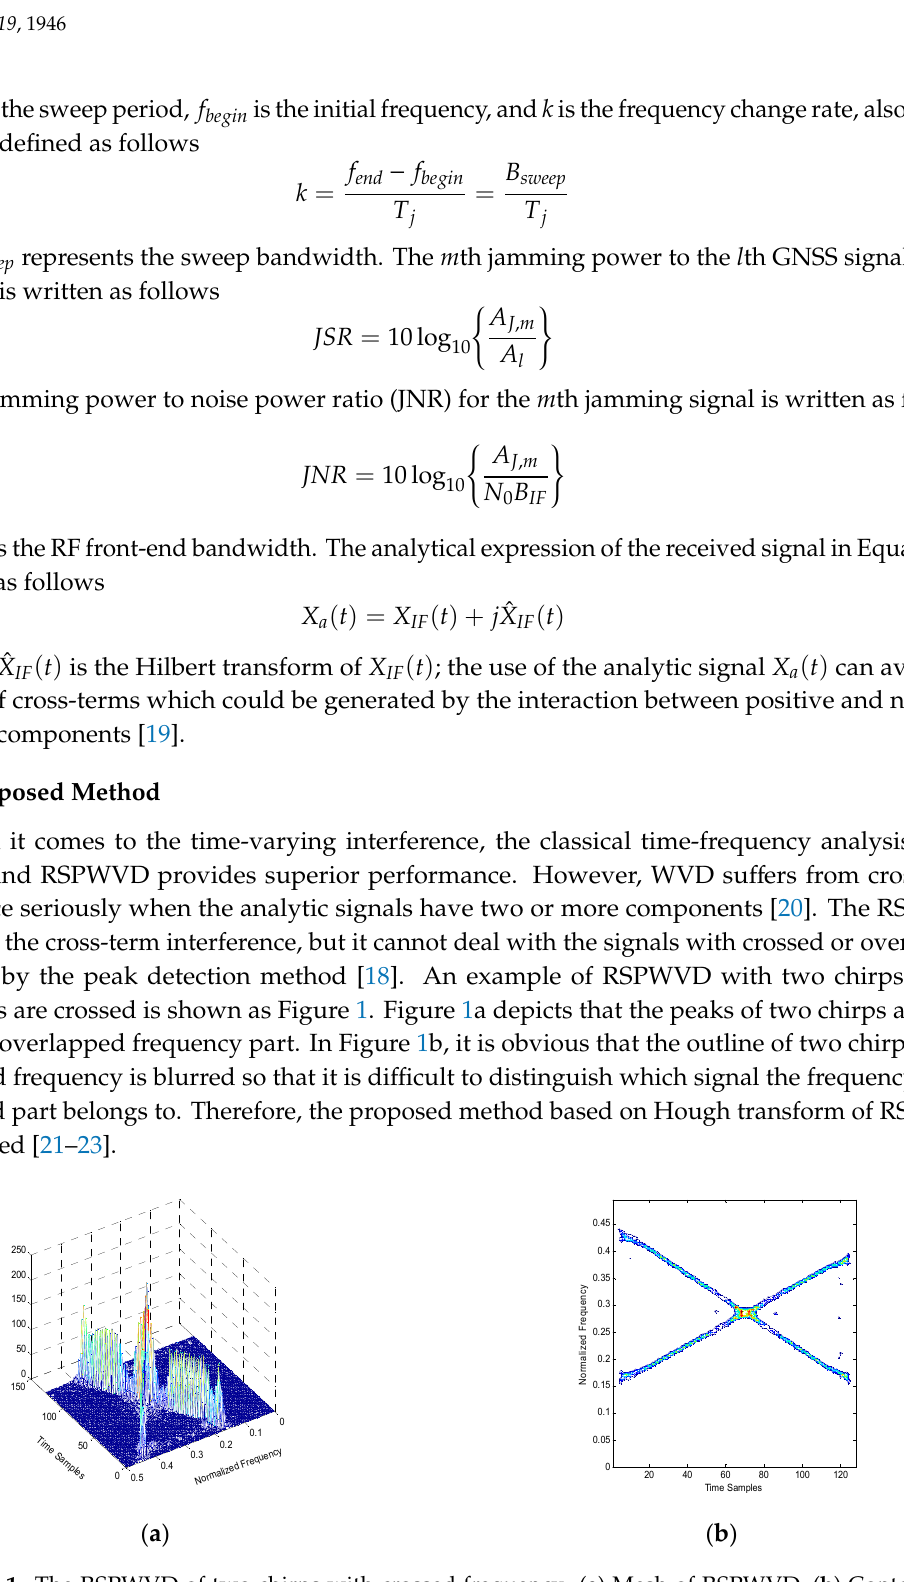
Figure 1. The RSPWVD of two chirps with crossed frequency. ( a ) Mesh of RSPWVD. ( b ) Contour of RSPWVD.